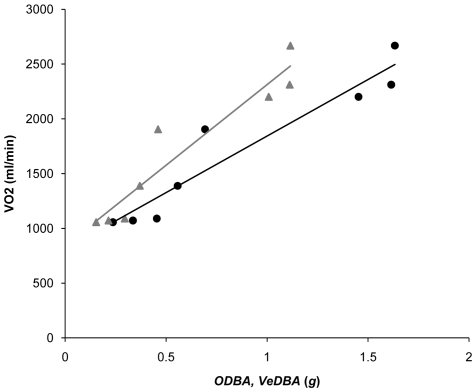
An example plot of  uptake against ODBA (black circles) and VeDBA (grey triangles) over the duration of the trial following removal of the points above the participant's anaerobic threshold.